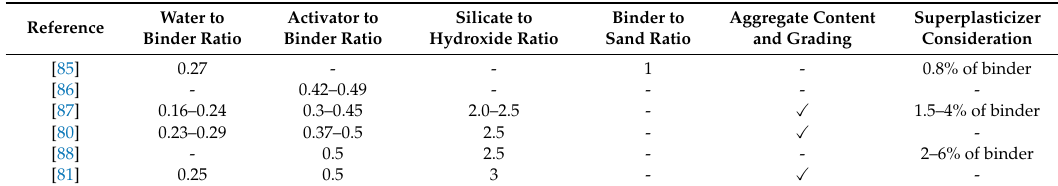
Figure 6. Mix design of GPC based on binder to sand ratio [84]. Table 3. Factors to be considered in mix design of di ff erent